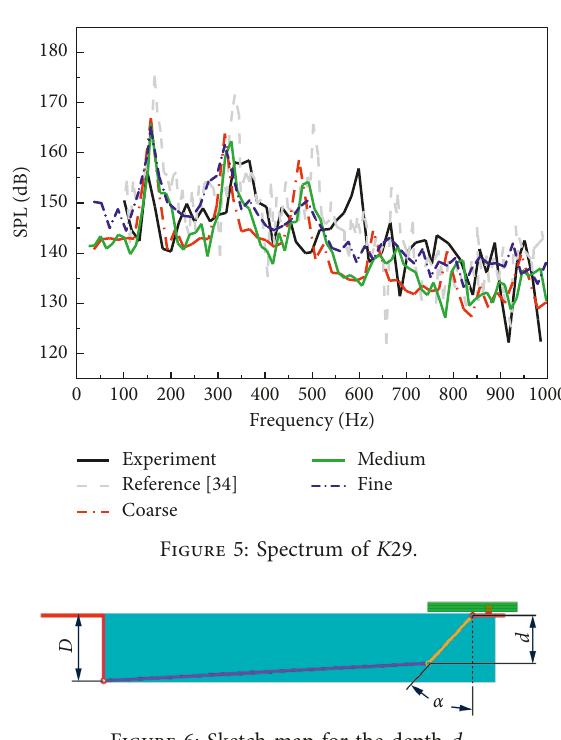
Figure 6: Sketch map for the depth d